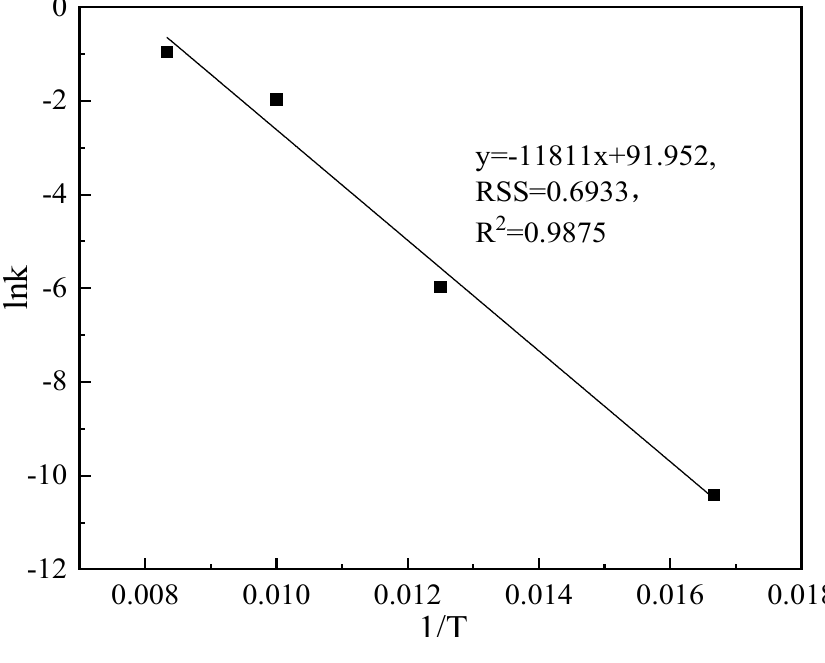
Figure 9. Relationship between lnk and